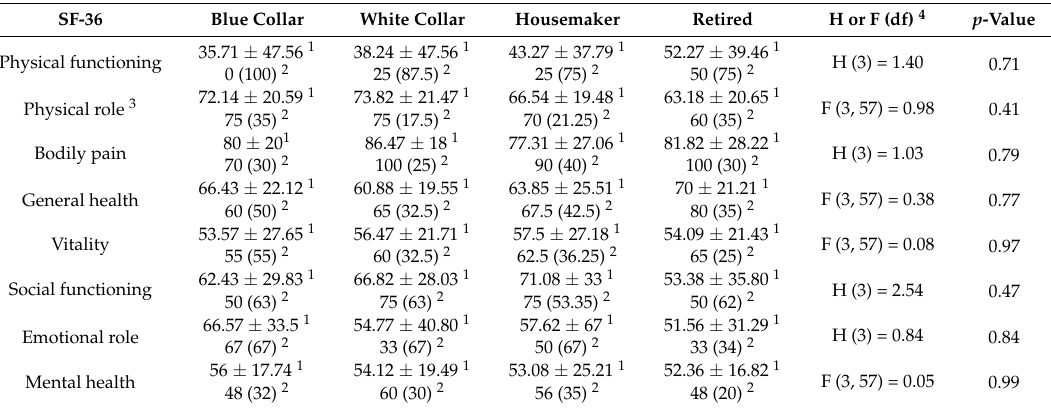
Table 7. Effects of work status on SF-36 subscales.